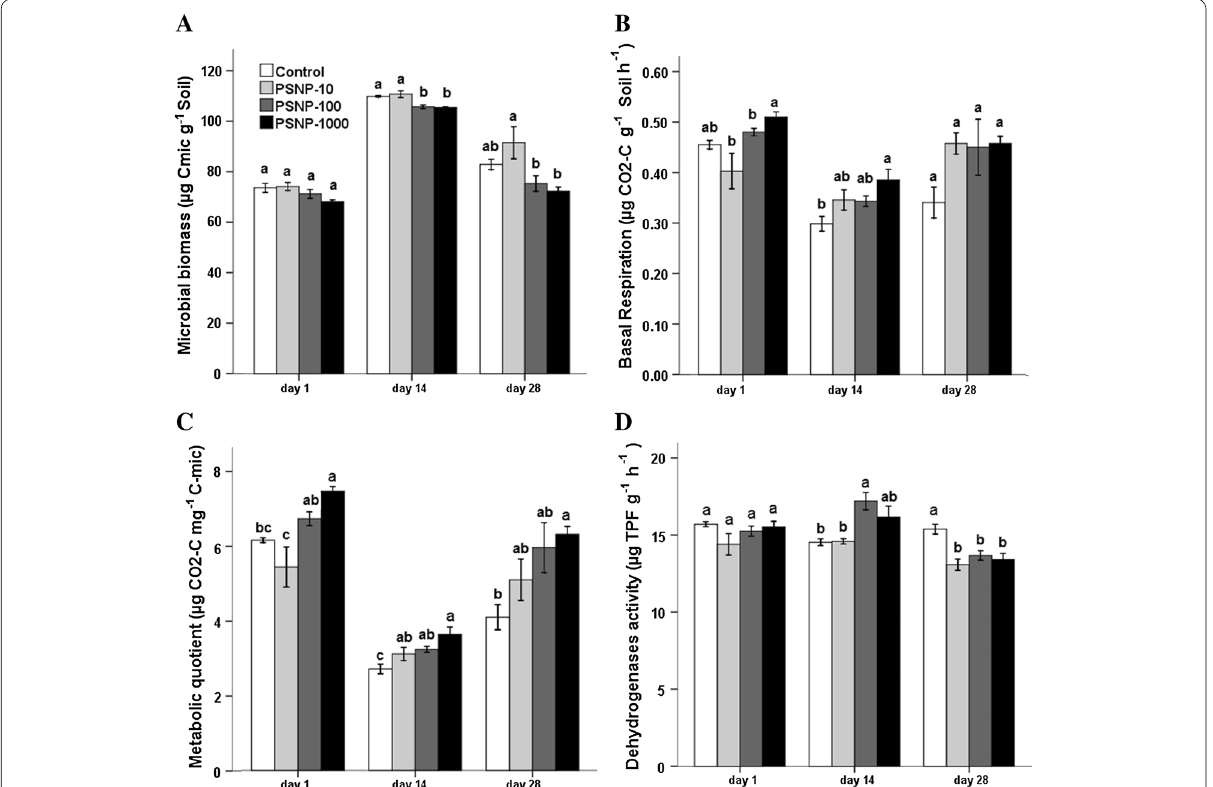
Fig. 2 Mean ( SE, n 4) of A microbial biomass‑C, B basal respiration, C metabolic quotient, and D dehydrogenases activity under different PS‑NP ± = concentrations of 10 (PSNP‑10), 100 (PSNP‑100), and 1000 (PSNP‑1000) μg kg − 1 dry soil at three time points during 28 days of incubation. Significant differences between the treatments are indicated by different letters (ANOVA and post hoc Tukey‑B test; p <